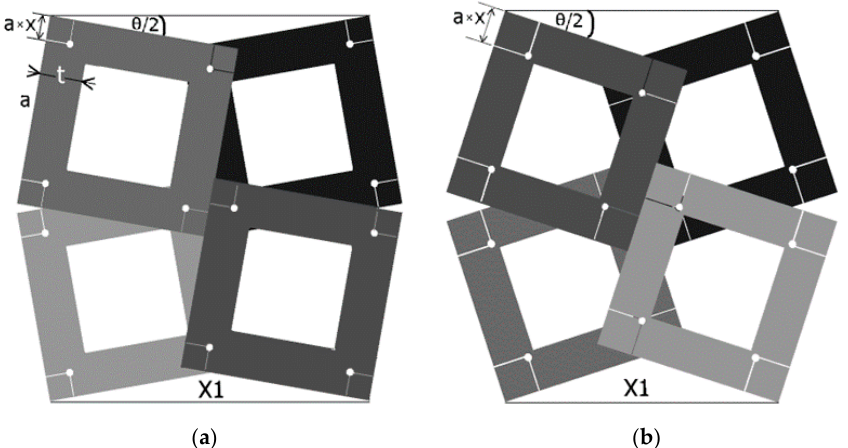
Figure 4. Structure of 2 × 2 rotating square frames in the closed position, with the geometric param- eters x and θ marked for two different values of the x parameter, (where ( a ) x = 0, and ( b ) x = 0.25), and the θ angle. ( b ) x = 0.25), and the θ